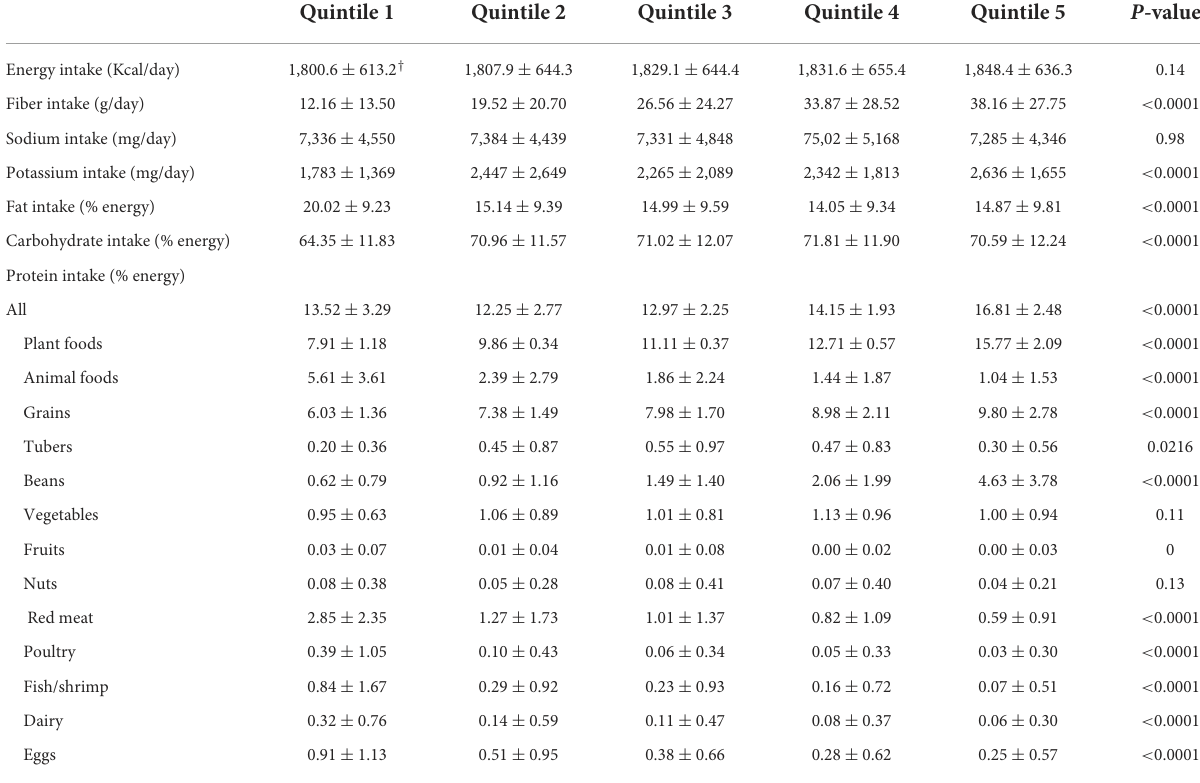
TABLE 2 Dietary intakes across quintiles of plant protein intake.